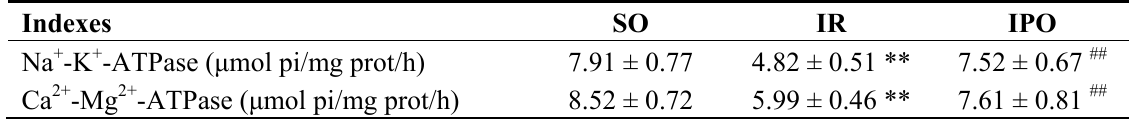
Table 5. Effect of ischemic postconditioning on myocardium Na + -K + -ATPase and Ca 2+ -Mg 2+ -ATPase activities in IR